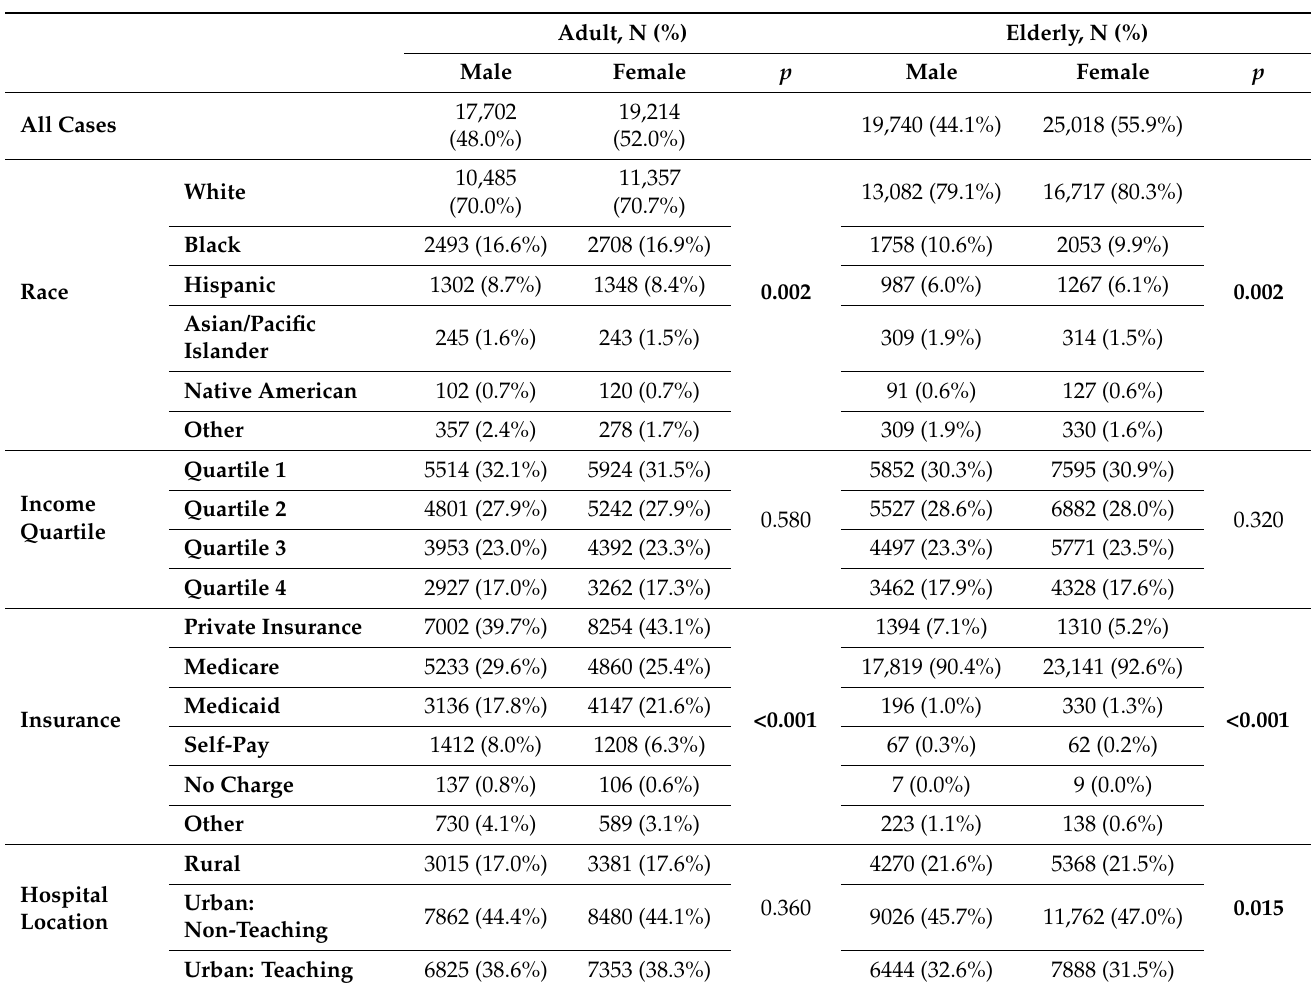
Table 2. Characteristics of emergency-admitted patients with the primary diagnosis of paralytic ileus (NIS 2005–2014). Data are stratified according to sex